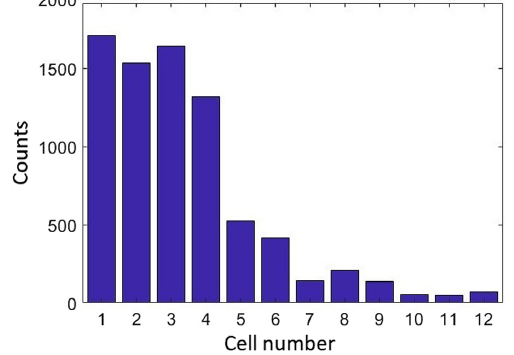
FIG. 10. BDs localization obtained by edge